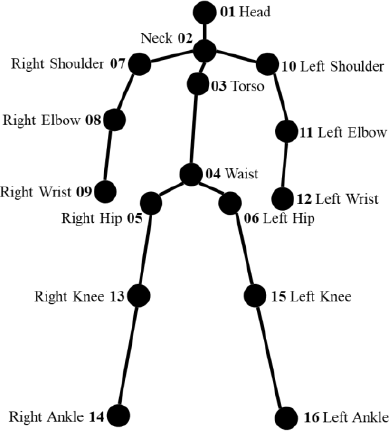
Figure 10. Body joints.